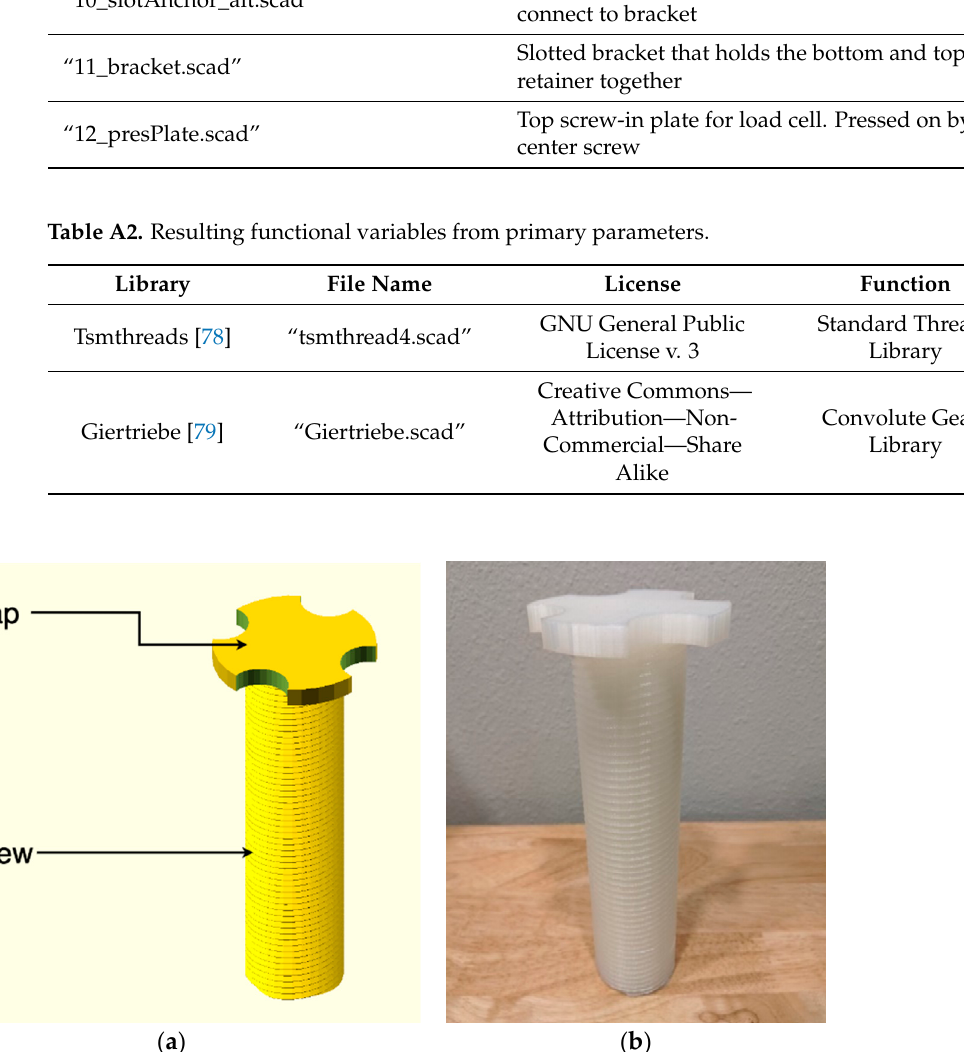
Figure A1. ( a ) Finished and labeled rendering of the central screw assembly. Note that when printed, the cap would be placed on the build plate and the assembly would be flipped 180 degrees. ( b ) Three-dimensional (3D)-printed central screw assembly. Printed on an open source PrusaMK3S with natural PLA at 0.2 mm layer Table A3. OpenSCAD central screw parameters.